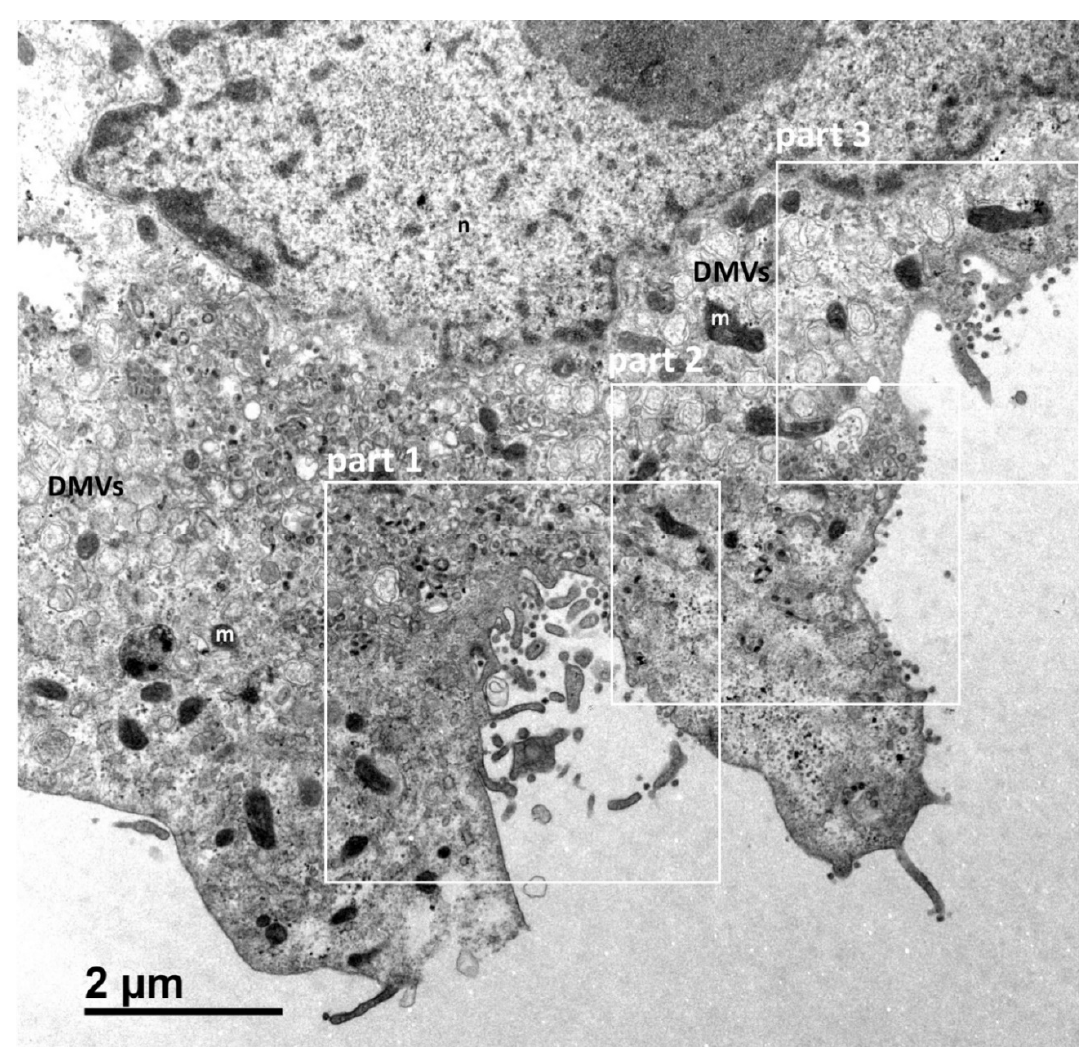
Figure 1. Vero cell at 10 h post-infection with SARS-CoV-2. This cell (cell A) is representative and shows the various virus release situations observed. The three areas delimited by white squares designate the regions of the cell analysed by the examination of serial sections in subsequent Figures 2–4: a region characterised by a large cytoplasm invagination rich in plasma membrane microvilli (part 1); a region in which the virus is released and the plasma membrane does not exhibit particular protrusion (part 2); and a region in which the situation is intermediate, with small plasma membrane microvilli at the cell surface (part 3). The cellular area between the cytoplasm invagination and the nucleus (n) contains a large number of viral particles. This area is flanked on both sides by numerous double-membrane vesicles (DMVs) and mitochondria (m).